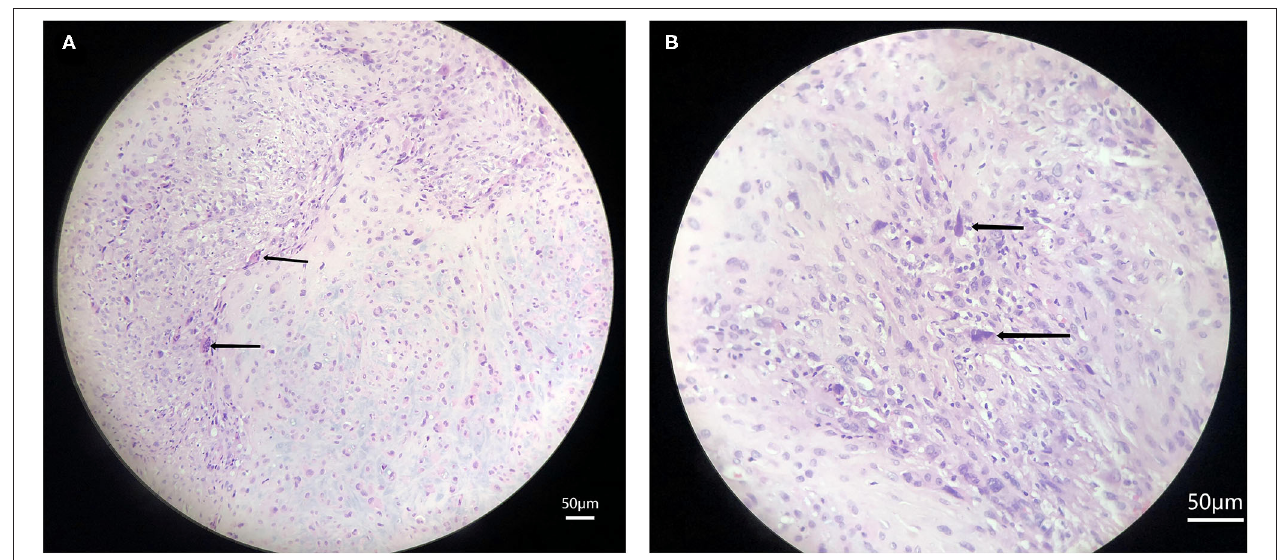
FIGURE 1 | Pathological slice of undifferentiated pleomorphic sarcoma. Arrows indicate that the tumor cells have obvious nuclear atypia and pathological nuclear mitosis. (A) 20X HE stain, (B) 40X HE stain.